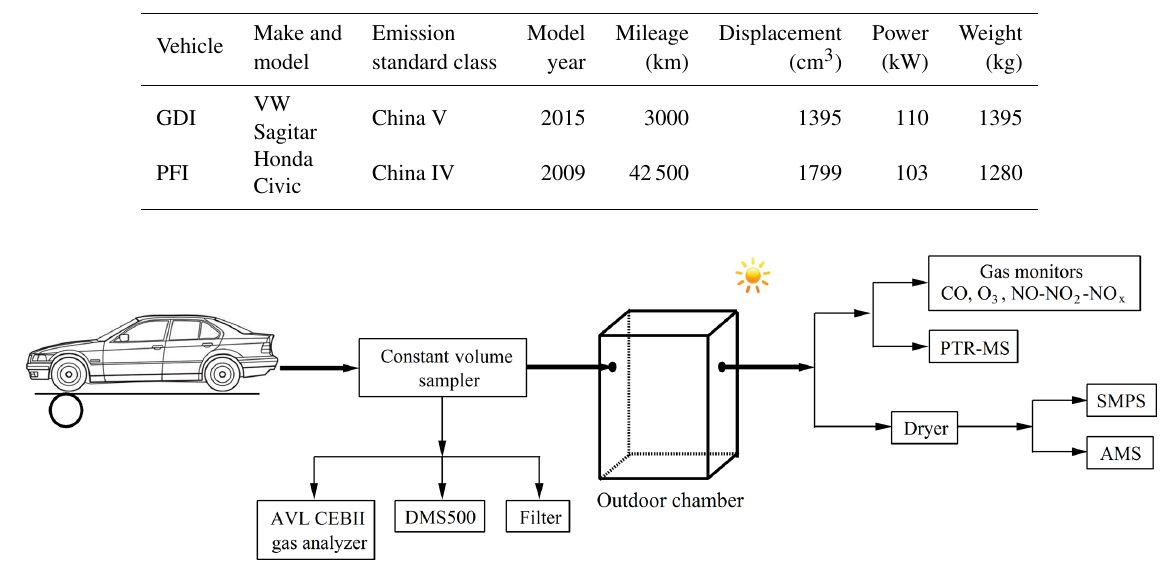
Table 1. Descriptions of the gasoline direct injection (GDI) and port fuel injection (PFI) vehicles used in the experiments.